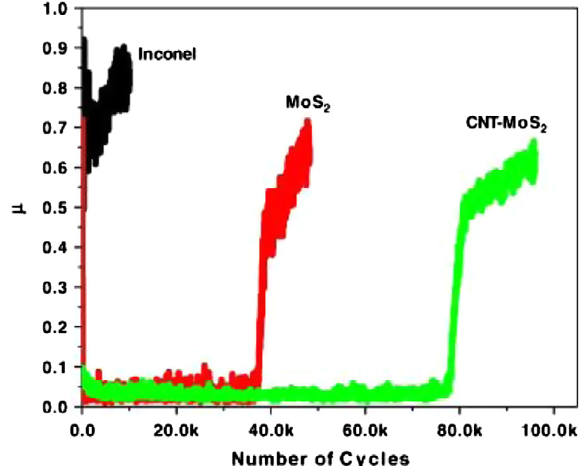
Figure 9. CoF measured in dry air using a 1 mm diameter alumina ball under 1 N load on bare Inconel disc, electrodeposited MoS 2 , and CNT-MoS 2 composite film plotted as a function of number of wear cycles [12,